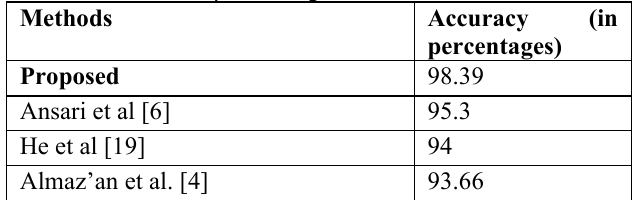
Table 2. Computation of accuracy for proposed and